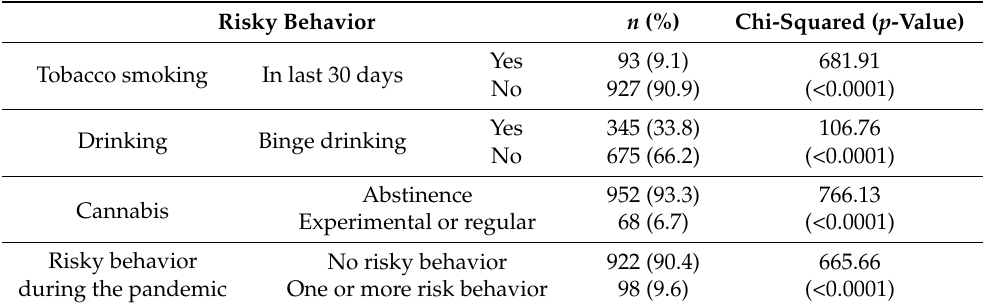
Table 2. Risky behavior characteristics ( n = 1020).